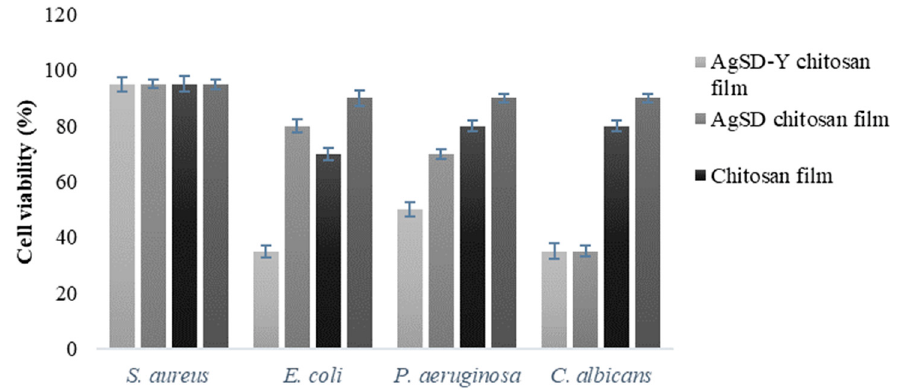
Figure 13. Tests (cell viability of S. aureous , E. coli, P. aeruginosa and C. albicans ) in liquid medium containing AgSD-Y / Chitosan film, AgSD / Chitosan film, Chitosan film or AgNO 3 . Results are the mean ± standard deviation ( n = 3).